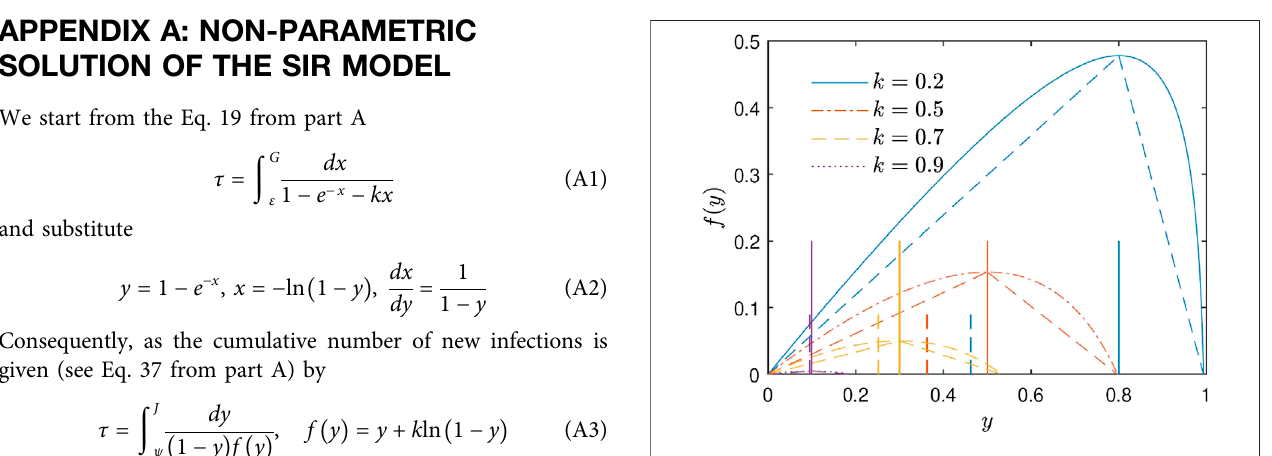
FIGUREB1| Comparisonoftheapproximation(B2)withtheexactcurve for f ( y ) for different values of k . Vertical solid lines mark the position of the maximum of the